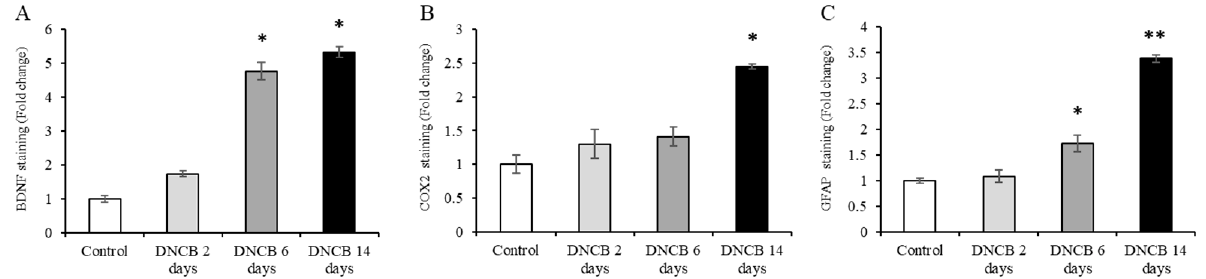
Figure 4. Quantification of atopic dermatitis (AD)-induced changes in the expression of neuroinflammation markers in the hippocampus. Neuroinflammation markers in the hippocampus were altered by AD. The changes in the expressions of brain-derived neurotrophic factor (BDNF), cyclooxygenase-2 (COX2), and glial fibrillary acidic protein (GFAP) were quantified using ImageJ software (NIH, Bethesda, MD, USA). ( A ) BDNF expression changes in the hippocampus. ( B ) COX2 expression changes in the hippocampus. ( C ) GFAP expression changes in the hippocampus. The data are expressed as the mean ± SD; * = p < 0.05, ** = p < 0.001, n = 5 per group.